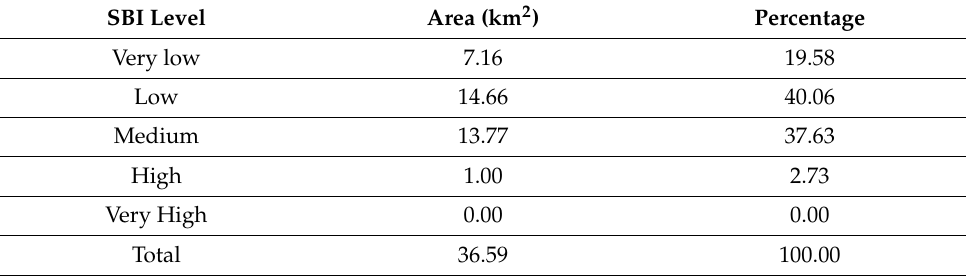
Figure 8. Level of social benefit in the study area using proposed SBI. Table 6. Area under different SBI level in the study area.